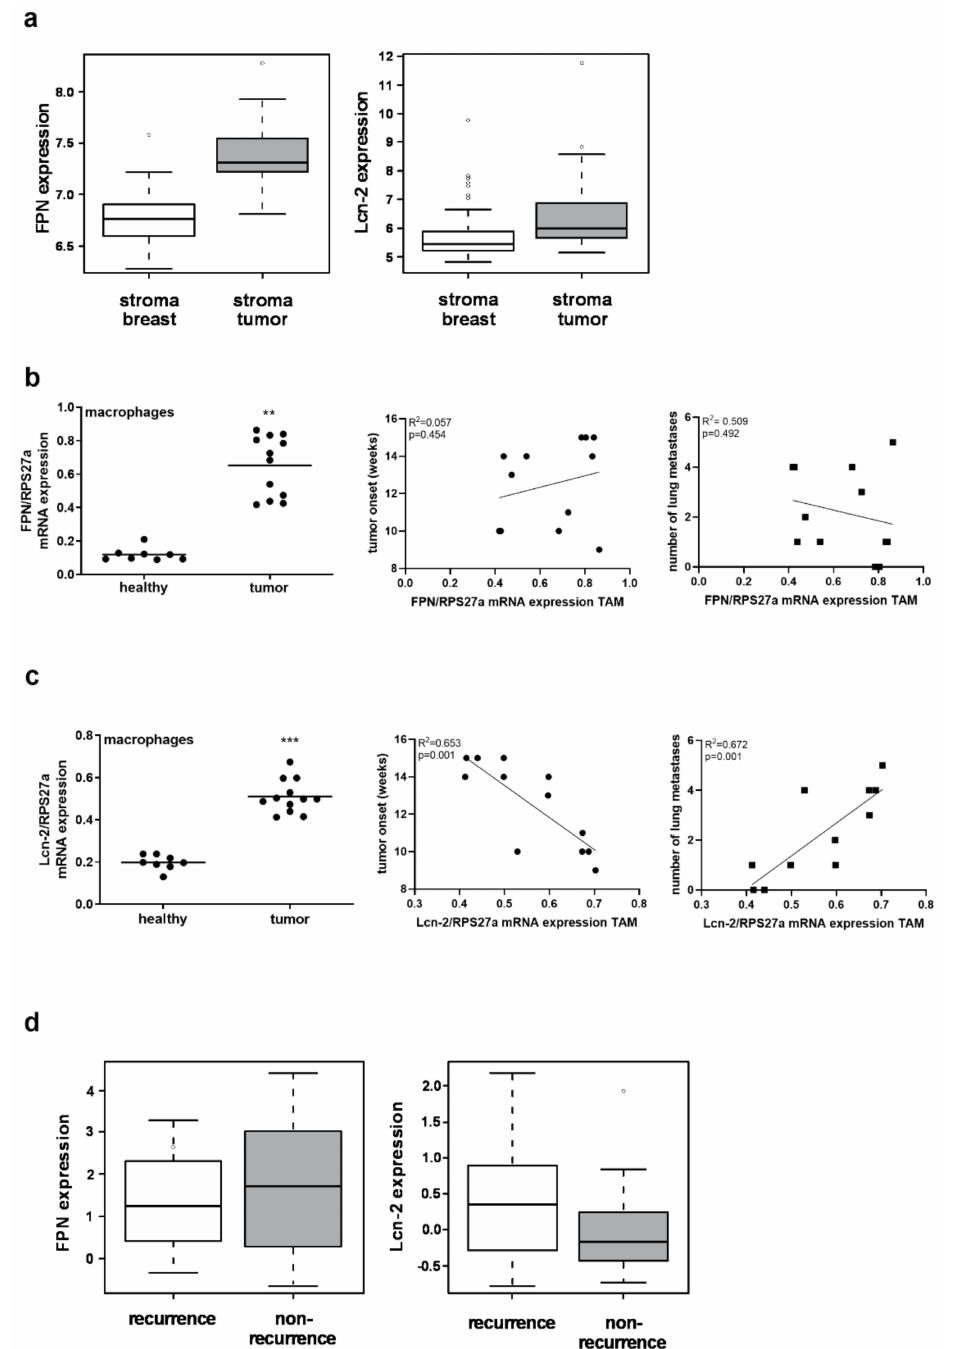
Scale bar: 5 mm ( b ) Quantification of stained iron amount in tissue sections by ImageJ. ( c , d , e ) Correlation of the tumor iron amount to tumor parameters: ( c ) tumor weight, ( d ) tumor burden, and ( e ) the number of affected mammary glands. ( f , g ) Analysis of TCGA-BRCA data sets from breast cancer compared to healthy tissue for the mRNA expression of ( f ) FPN and ( g ) Lcn-2 (n = 110). ( h , i ) Quantification of the mRNA expression of ( h ) FPN and ( i ) Lcn-2 in whole tumor homogenates from wildtype PyMT mice compared to murine healthy breast tissue. Graphs are displayed as means ± SEM. Statistically significant differences were calculated after analysis of variance (ANOVA) and Bonferroni’s test, with * p < 0.05, ** p < 0.01. Data significance of correlations was determined by Spearman’s test.